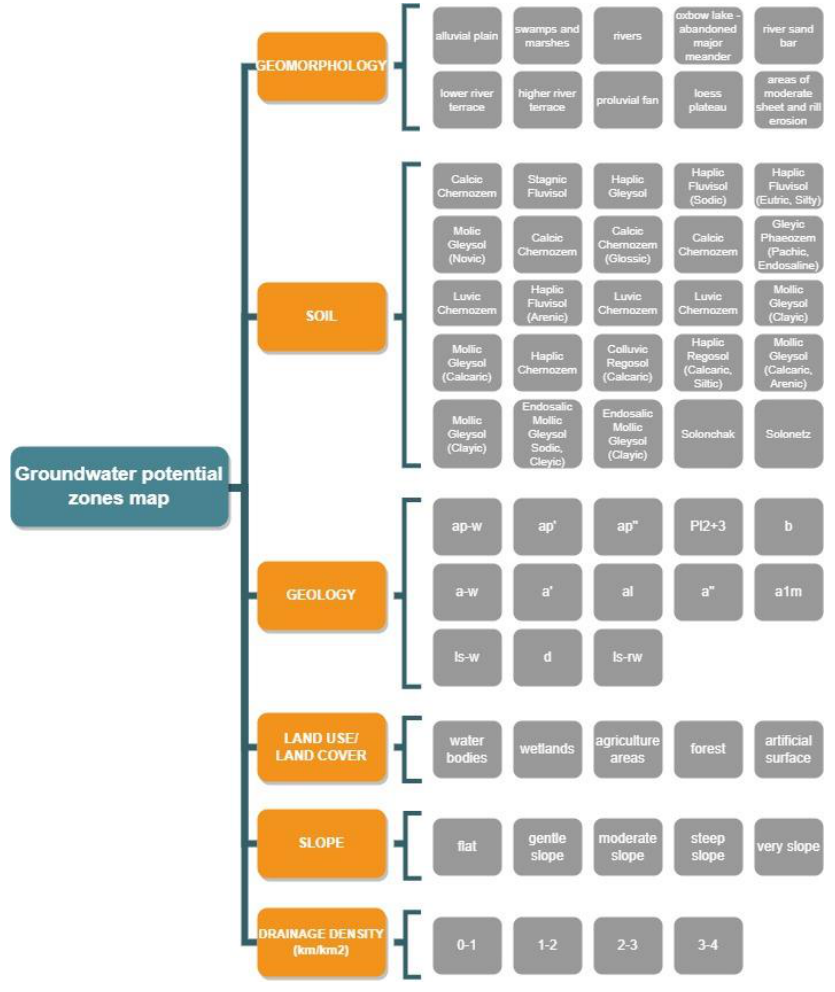
Figure 3. Hierarchical tree.